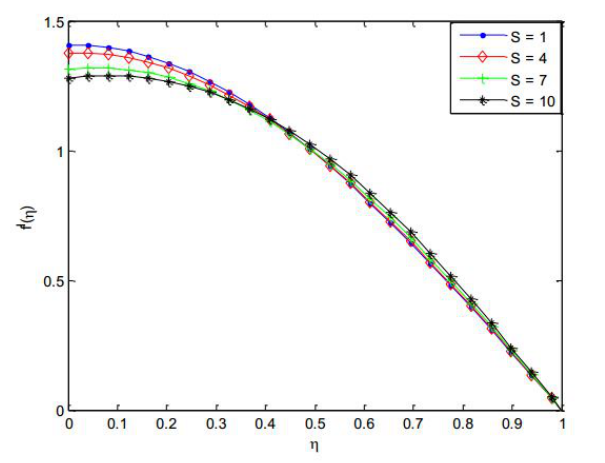
Figure 6. Effects of Squeezing number on the